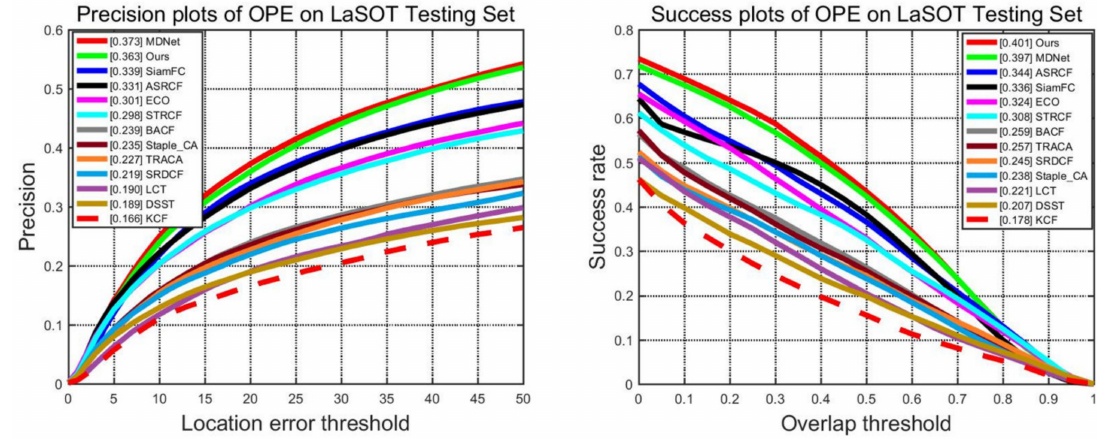
Figure 6. Precision plots and success plots of OPE on LaSOT test